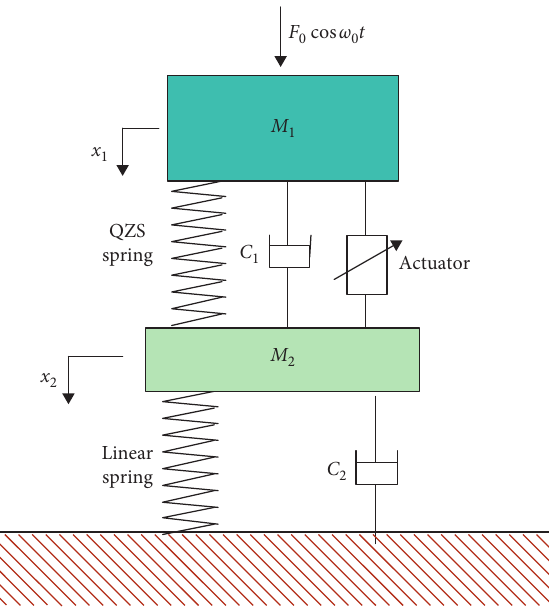
Figure 8: The structure diagram of a double-layer QZS